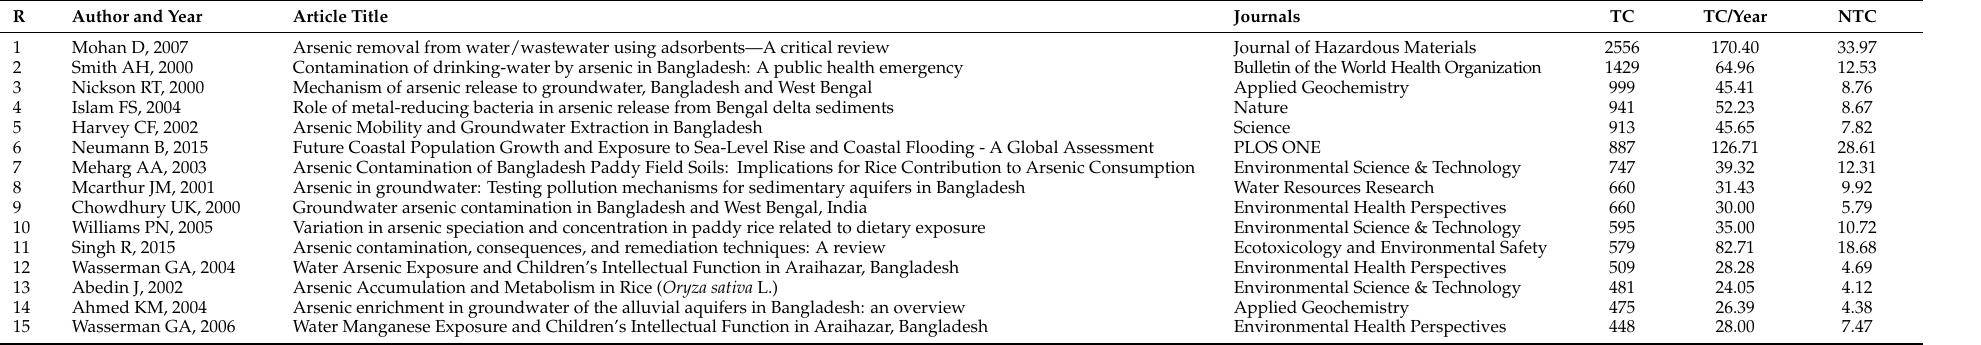
Table 6. Top 15 most globally cited articles in Bangladesh water-research-related publications (Note: TC and NTC represent total citations and normalized total citations,